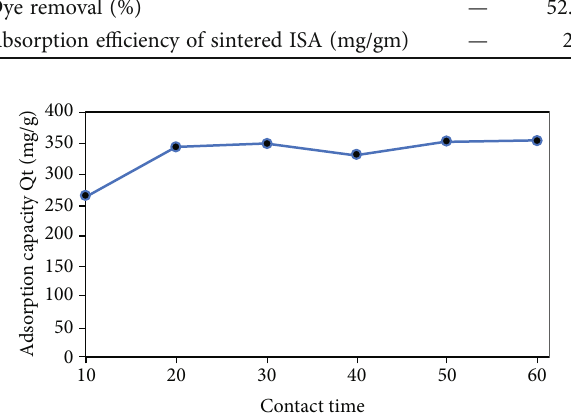
Figure 9: E ff ect of the contact time on adsorption capacity of sintered ISA for methylene blue